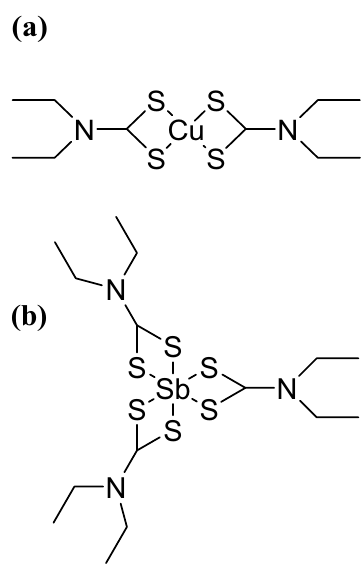
Figure 1. Figure showing the chemical structures of the two single-source precursors utilised in this report. These are ( a ) copper(II) diethyldithiocarbamate (Cu(DTC) 2 ) and ( b ) antimony(III) diethyldithiocarbamate (Sb(DTC) 3